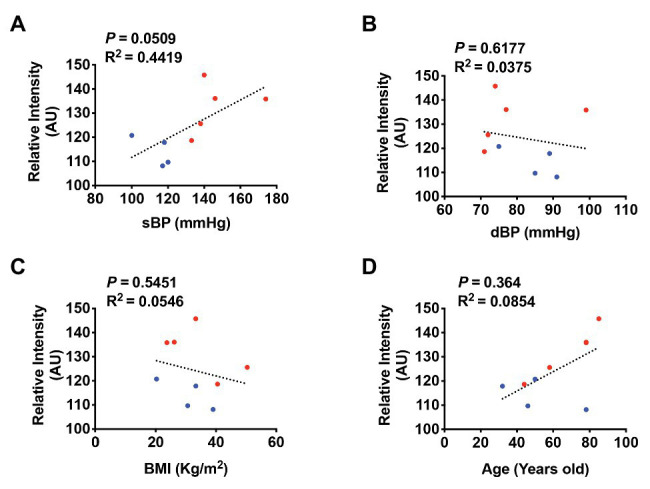
PRR immunoreactivity is not significantly correlated with sBP in the RVLM of the human brain. A least-square correlation post analysis was used to calculate the correlation between the relative intensity of PRR immunoreactivity and sBP (A), dBP (B), BMI (C), and age (D). N = 9.